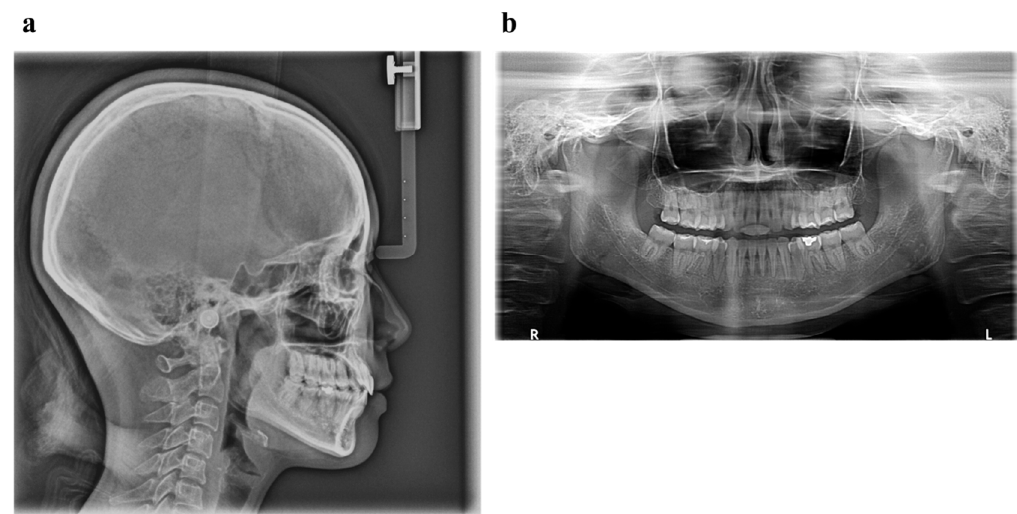
Figure 15. Post treatment radiographs ( a ), lateral cephalogram; ( b ), panoramic radiograph).